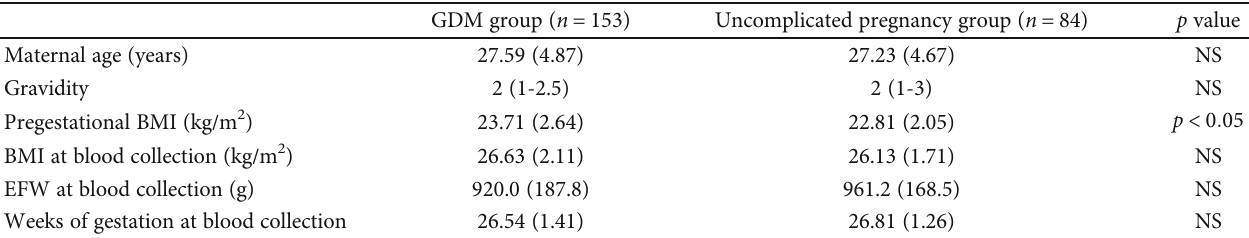
Table 1: Baseline clinical characteristics (mean and standard deviation; median and range 25-75 percentile for gravidity).